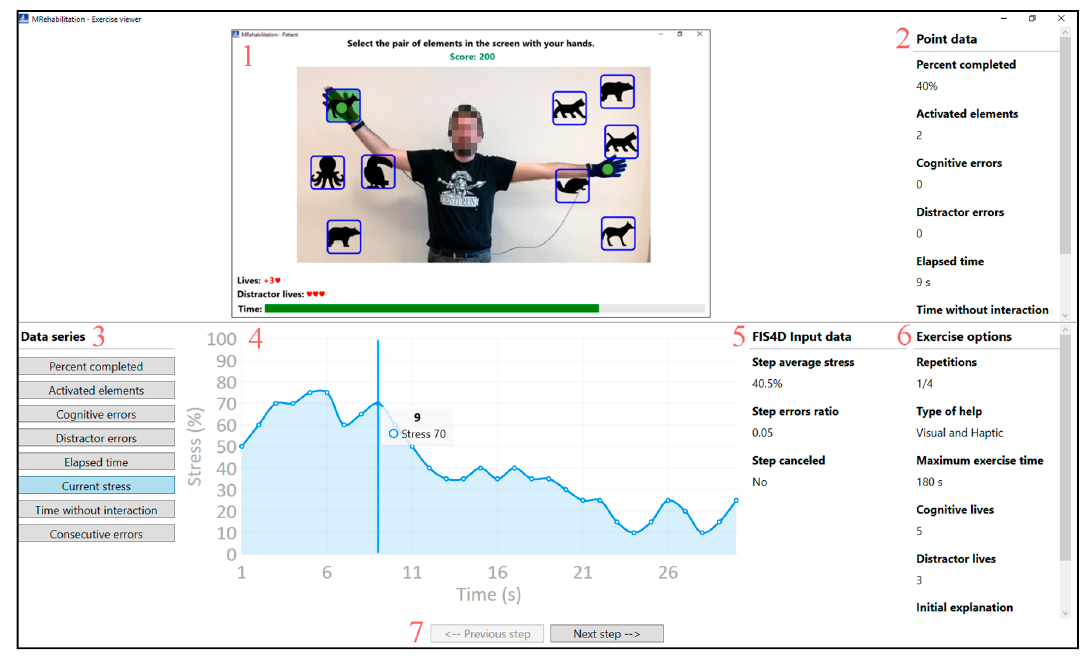
Figure 9. Remote exercise viewer.